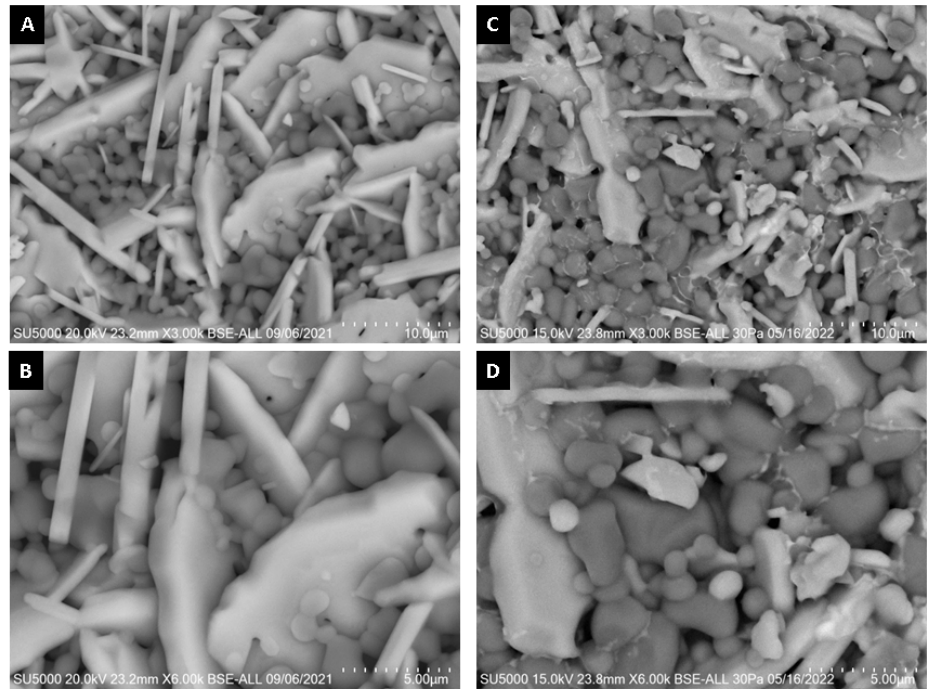
Figure 16. SEM surface micrographs of alumina spheres ( A , B ) before adsorption and ( C , D ) after Cd(II) adsorption.